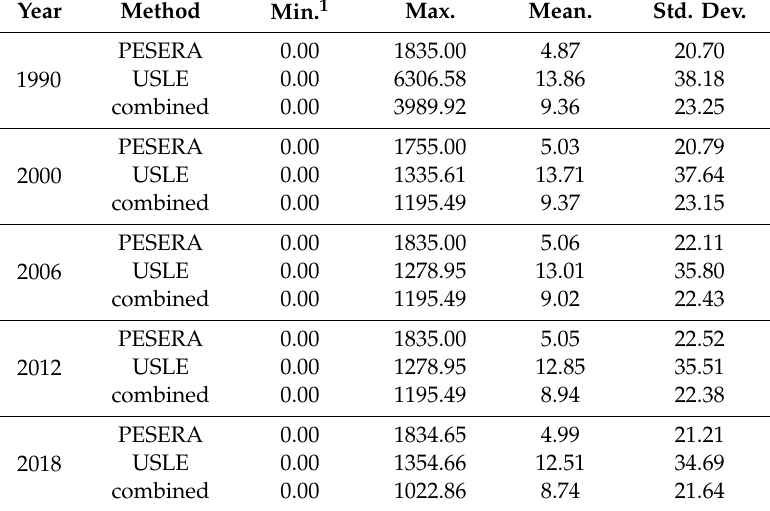
Table 5. Descriptive statistics on the e ff ects of LULC changes and di ff erent modeling methods on erosion estimates (in t / ha /